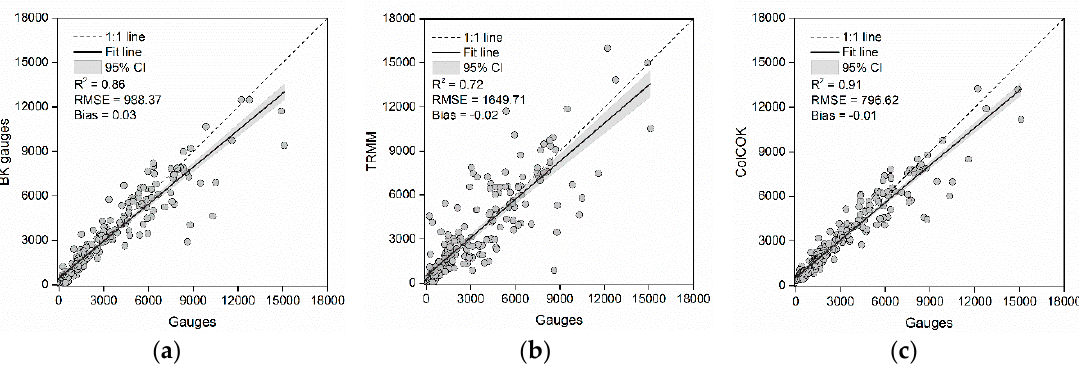
Figure 6. Scatter plot between the rain gauge calculated annual R factor and the estimated annual R factor from: ( a ) BK gauges, ( b ) TRMM, and ( c ) ColCOK, based on the 217 testing data set for 2002–2013. Table 3. Overall performance of validation results of the BK gauge-, TRMM-, and ColOCK-based yearly rainfall erosivity estimates in comparison with the 217 testing rain gauges